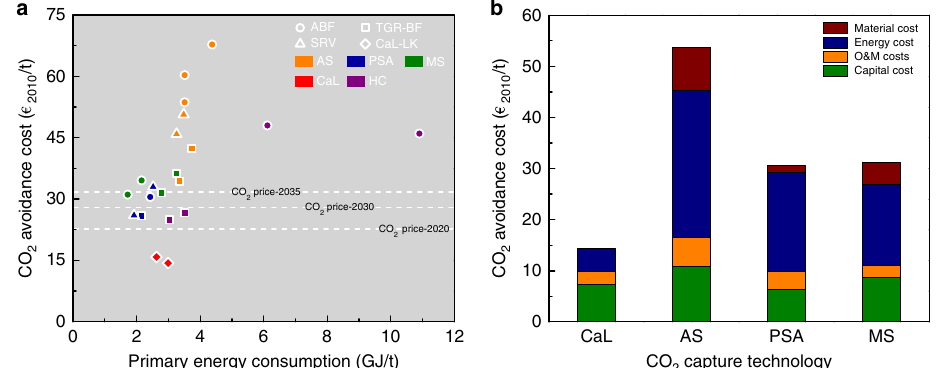
Fig. 4 Techno-economic superiority of the CaL-LP scheme for low-carbon steelmaking. a CO 2 avoidance cost and primary energy consumption, and b cost structure of various options to reduce CO 2 emissions in the iron and steel industry. The iron and steel production facilities: ABF, air-blown blast furnace; TGR-BF, top gas recycling-blast furnace; SRV, smelting reduction vessel; CaL-LK, calcium-looping lime kiln; and the CO 2 capture technologies: AS, amine scrubbing; PSA, pressure swing adsorption; MS, membrane separation; CaL, calcium looping; HC, hydrate crystallisation